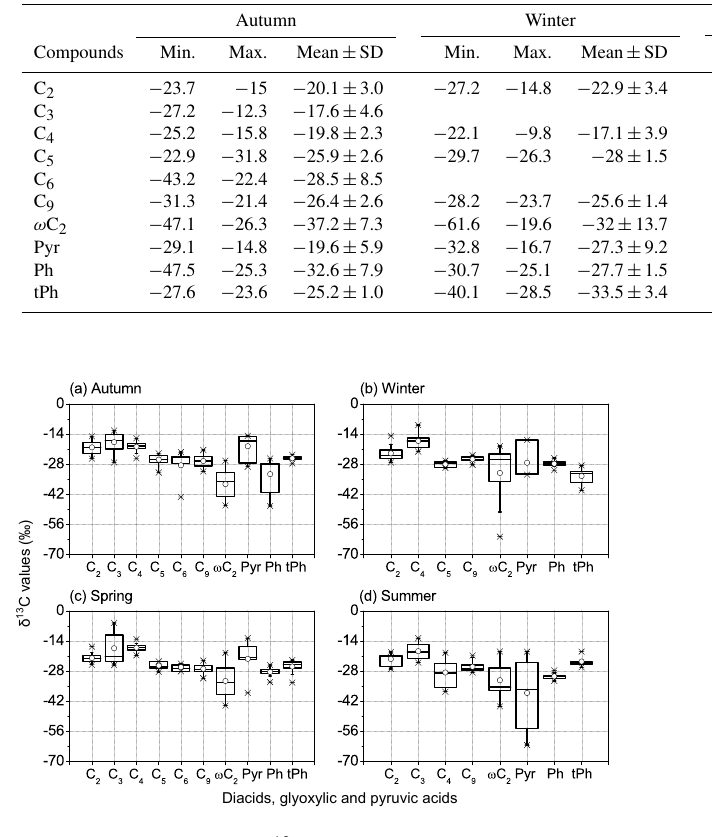
Figure 6. Box plot of the δ 13 C values of diacids, glyoxylic and pyruvic acids. The small circles represent the average δ 13 C values.